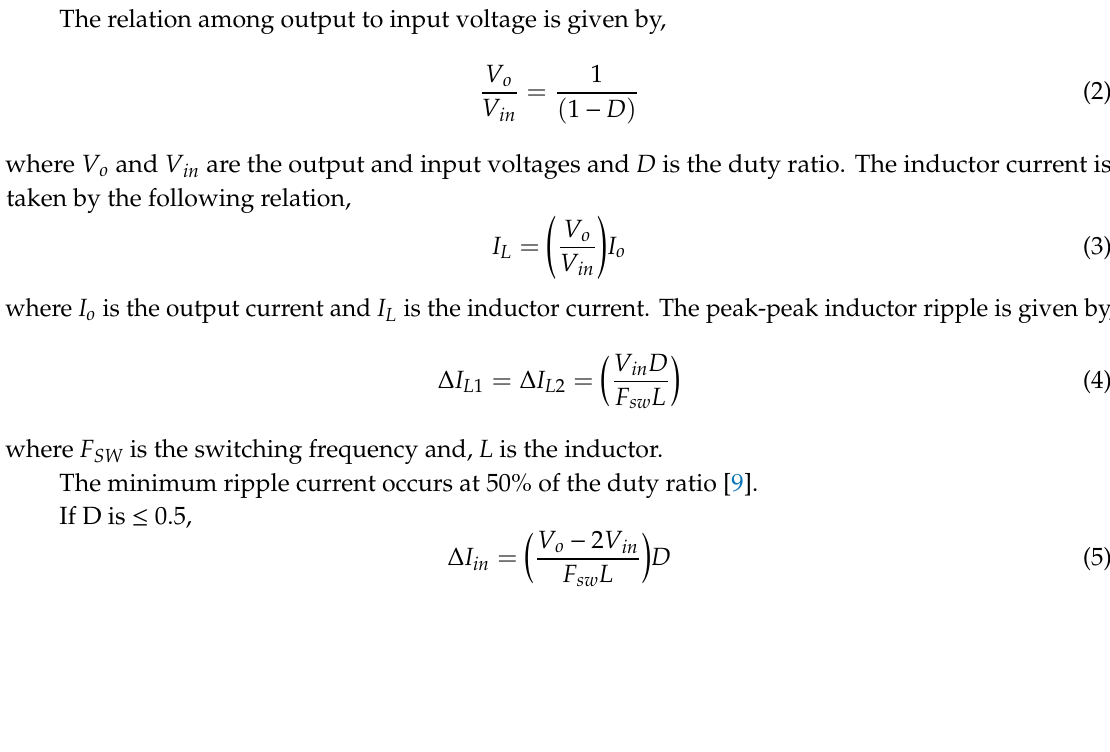
Figure 5. Interleaved boost converter (IBC) circuit diagram.